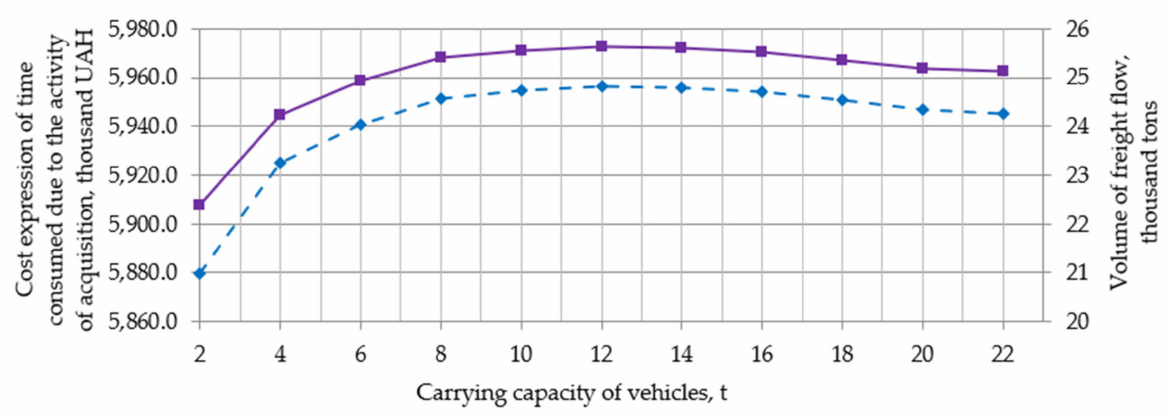
Figure 11. Changes in the value of time consumed due to the purchase in relation to the vehicles’ capacity: —volume of goods under the distribution scenario, t; —cost expression of time consumed due to the activity of acquisition, UAH.